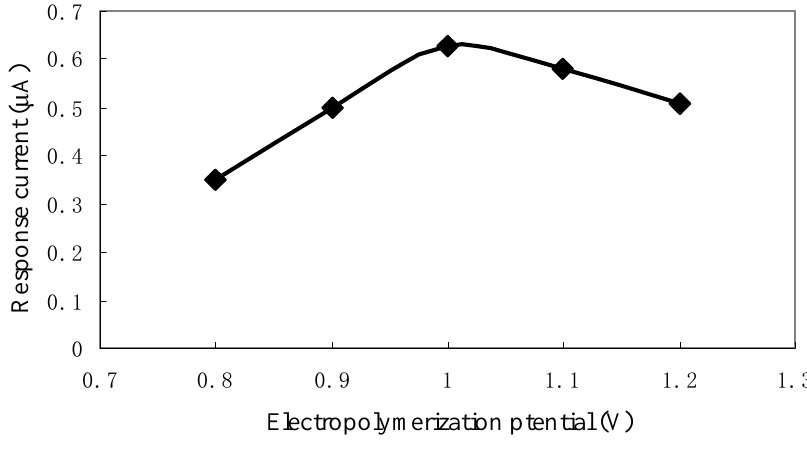
O (1 µ L, -300 mV potential applied). 2 2